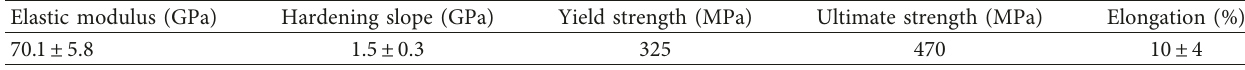
Table 3: Mechanical properties of 2A12-T4 aluminum